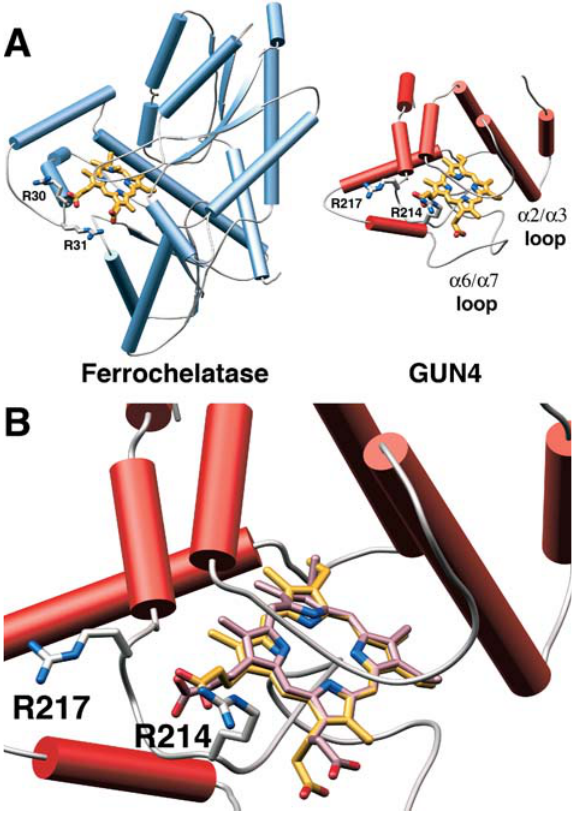
Figure 6. Model of a Putative SynGUN4 Porphyrin Complex Compared to an Experimentally Determined Structure for Ferrochelatase Bound to